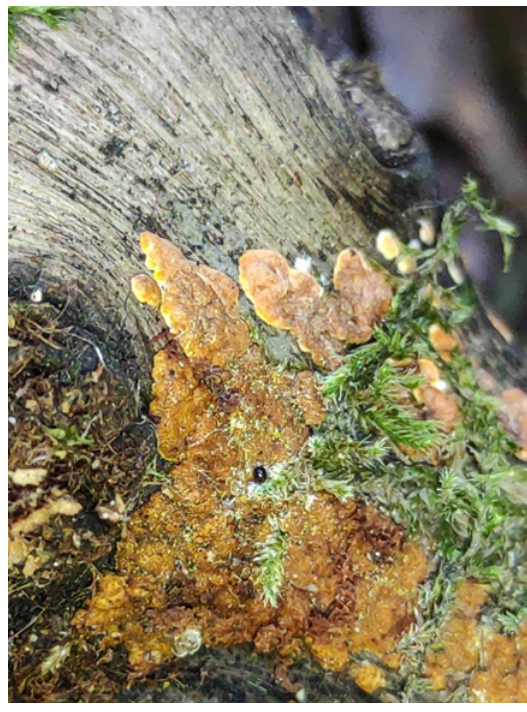
Figure 1 Stromata of Hypocrea auranteffusa from Kampinos National Park; October 9, 2021. Photography by A.